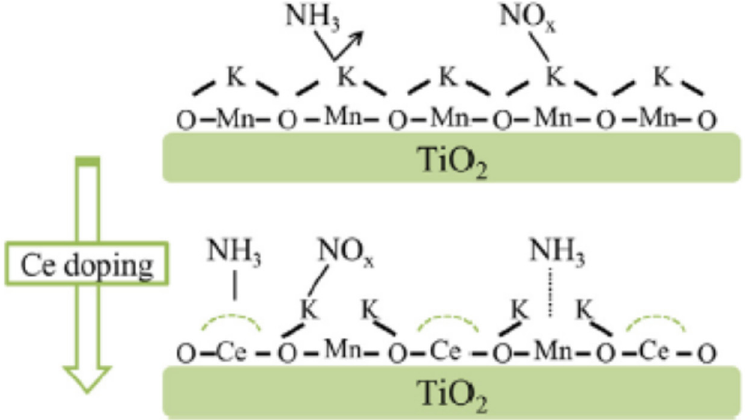
Figure 4. A schematic of the promotion alkali resistance mechanism of Ce on Mn / Ti catalyst. Reproduced from Reference [52].